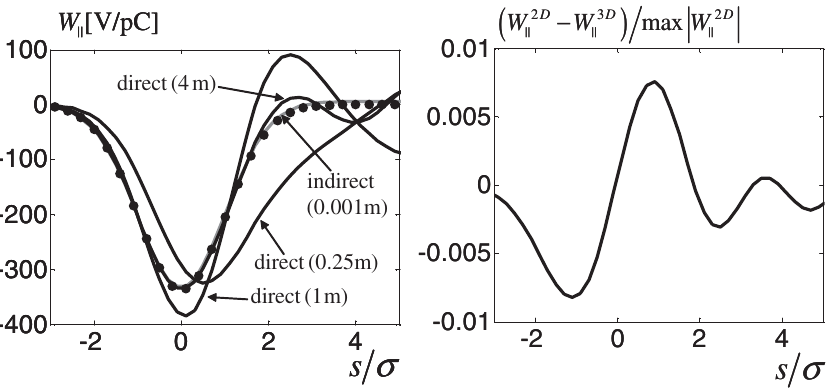
FIG. 7. Wake potentials for the round stepped collimator calculated with direct and indirect methods. Comparison of indirect wake potentials calculated with 2D (Sec. II B) and 3D (Sec. III D)